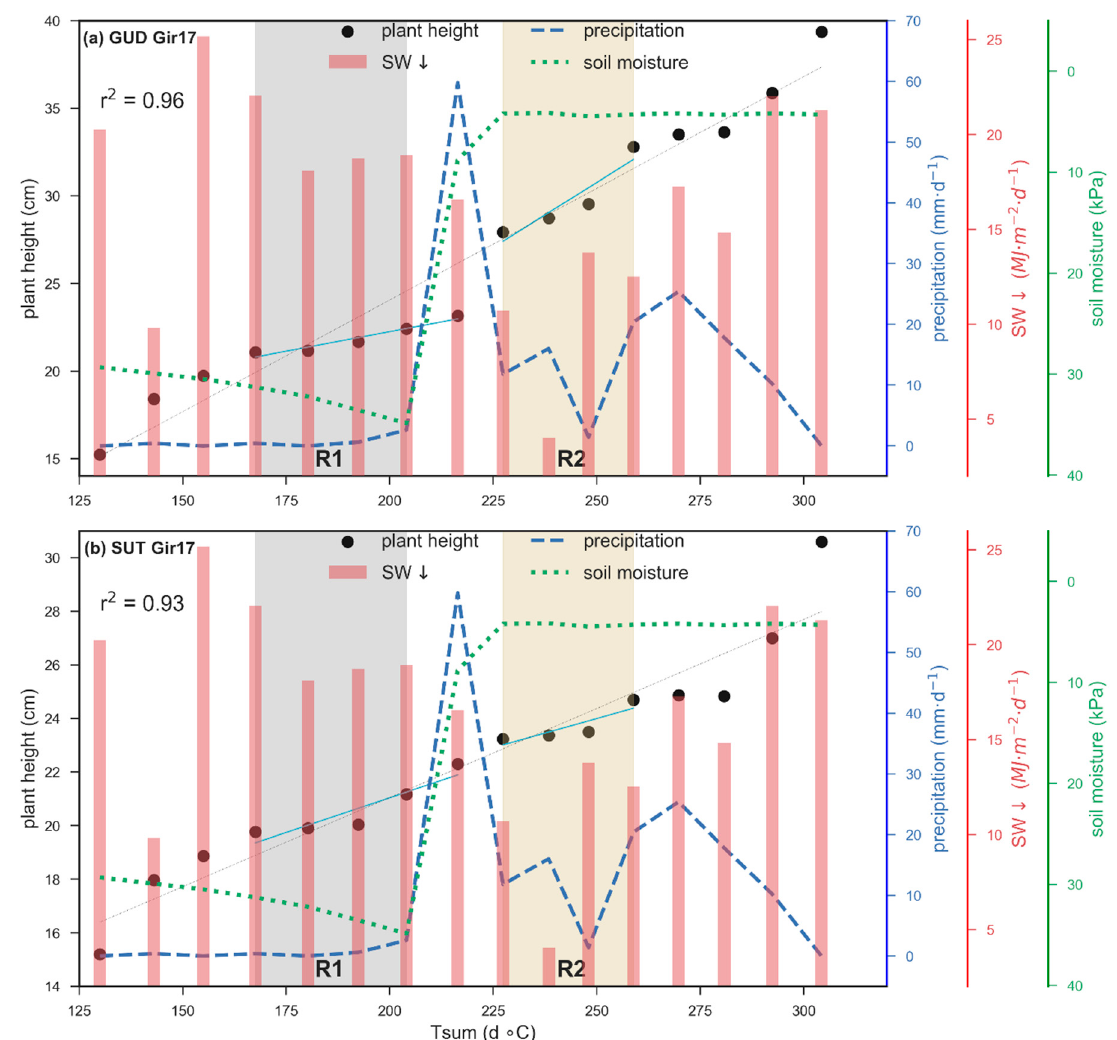
Figure 4. The correlation between Tsum (d ◦ C) and plant height (cm) for Gudene ( a ) and Suthalo ( b ) cultivars at the Gircha farm in belg -2017 at the times that the dips in the rate of increase in plant height occurred (we zoom into the highlighted spots using daily data) in Figure 3a,c. The daily total precipitation (mm · d − 1 ) (blue y -axis), daily total SW ↓ (MJ · m − 2 · d − 1 ) (red y -axis), and soil moisture tension ( ψ ) (kPa) (green and inverted y -axis) are shown on the right-side y -axis. The +/bar/line plots’ colors correspond to the colors of the y -axis. ( R1 ) shows moisture limited and ( R2 ) radiation limited regimes during this part of P1. The thin gray line shows the linear correlation line. The cyan colored lines in the shaded regions show the linear trend for the moisture and radiation limited periods during P1. The ψ is an average of four records, which are measured at four soil depths (5, 10, 20, and 40 cm) and the averages of the four sensors are reported. Note that soil moisture sensors measure from 200 kPa (dry soil) to 0 kPa (fully saturated soil).